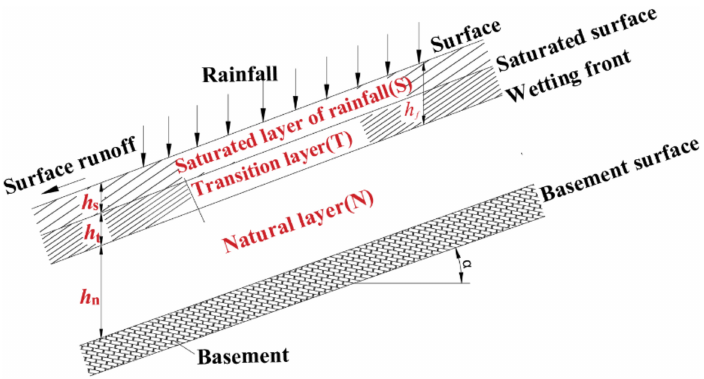
Figure 3. Model for calculating the safety factor in the rainfall infiltration process.